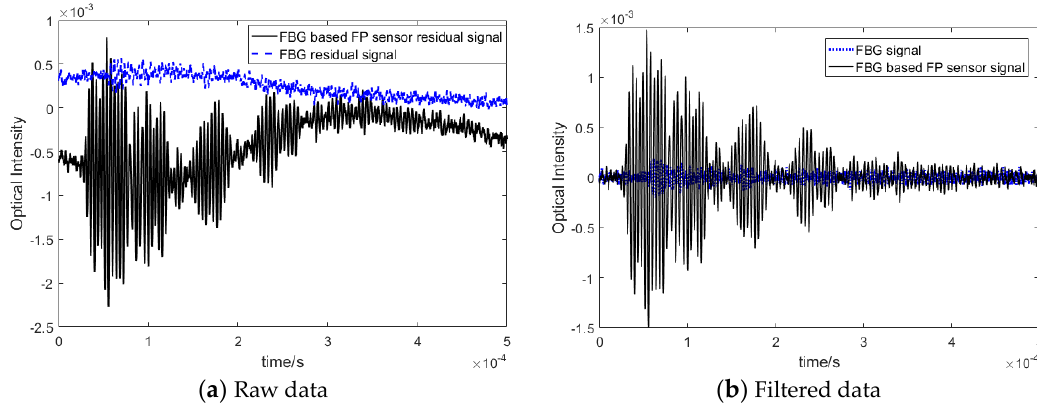
Figure 18. Comparison of a residual signal recorded by FBG-based FP and FBG sensors for different frequencies.